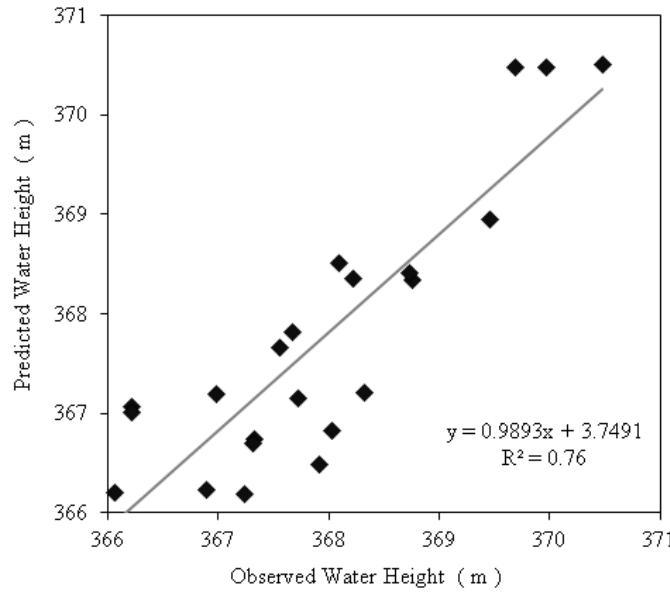
Figure 2. Comparison of observed water heights measured using piezometers versus predicted water heights modeled using